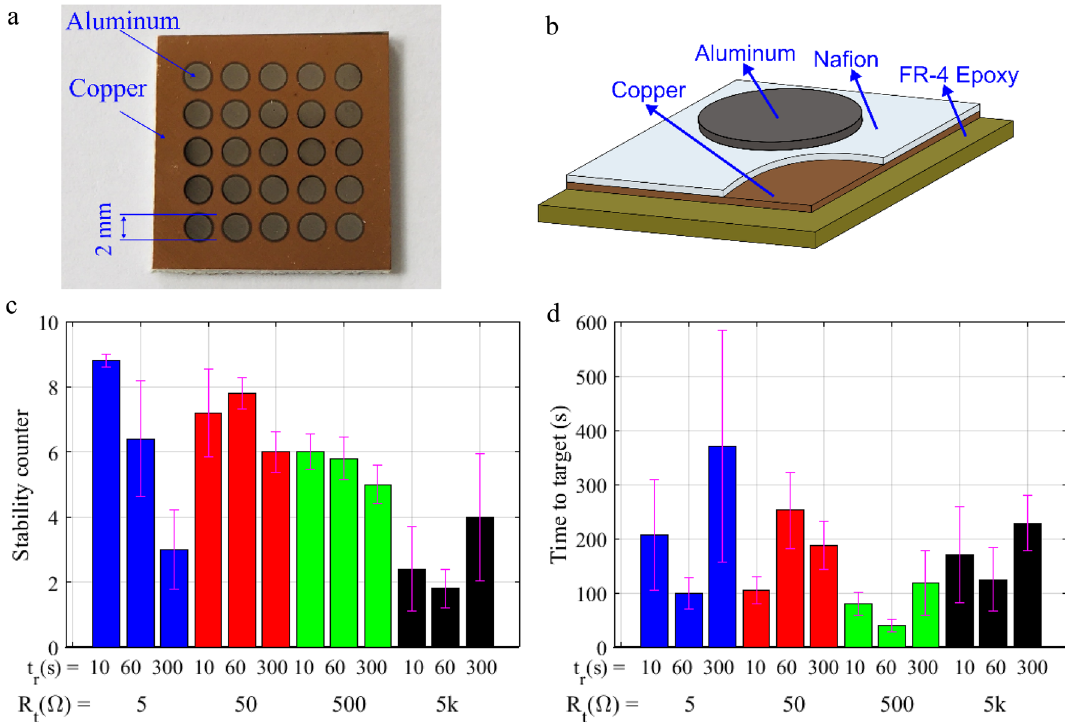
Figure 4. CBRAM switch cells on copper cladded FR-4 substrates used for DC characterization studies. ( a ) Photograph of fabricated CBRAM switch cell matrix. ( b ) Layer structure of a single cell of this group. DC